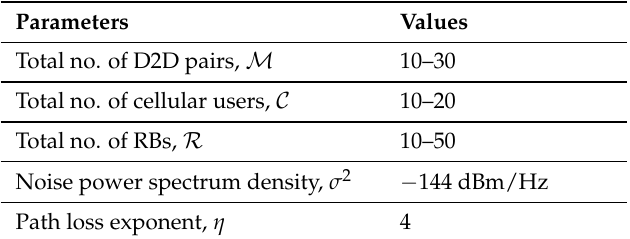
Table 3. Simulation